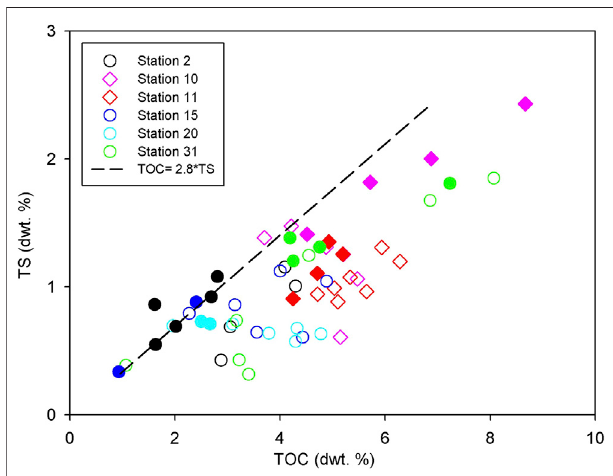
FIGURE 8 | Covariations of TS versus TOC including the relationship suggested for Holocene siliciclastic sediments (Berner, 1982). It is assumed that TS essentially consists in the investigated samples essentially of pyrite sulfur. Surface sediments < 20 cmbsf are open symbols and > 20 cmbsf are fi lled symbols.